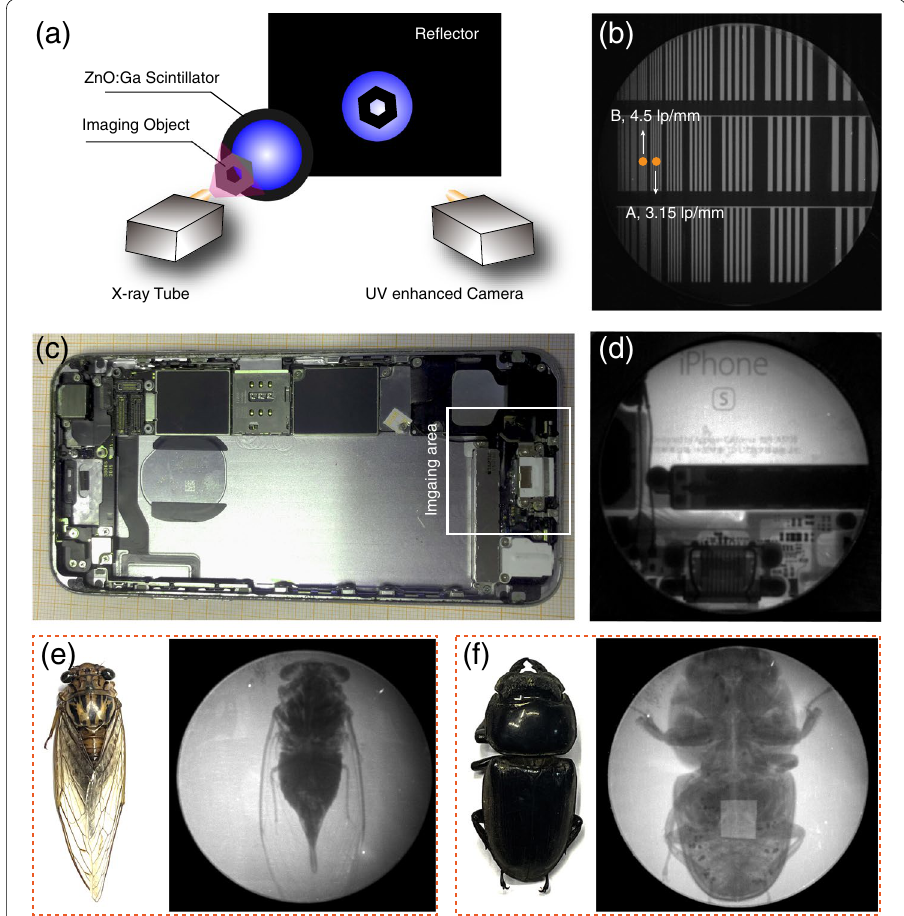
Fig. 5 X-ray imaging of ZnO:Ga wafer. a Measurement schematic of the X-ray imaging. b Image of the test-pattern plate under X-ray excitation, showing a 4.5 lp/mm resolution ratio. c and ( d ) Photographs of integrity chip of iphone 6 s under X-ray radiation and white light. e and ( f ) Photographs of arcane beetle specimen and cicada specimen under white light and X-ray radiation. All the above-mentioned X-ray imaging patterns can display rich and clear details of the imaged